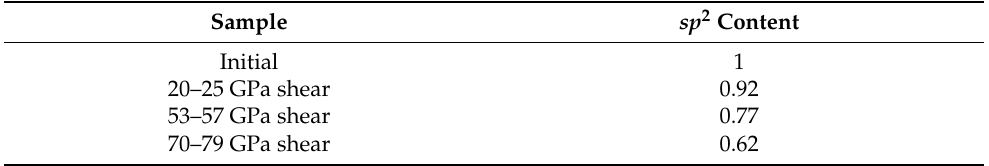
Table 2. The sp 2 content using the approach described in Reference [26]. The area under the sp 2 peak (280–285 eV) was divided by the value of the area of the sp 3 peak (286–292 eV). As we can see, the concentration of nitrogen decreases, as well as the concentration of the sp 2 bonds, with increasing pressure in the quenched specimens.